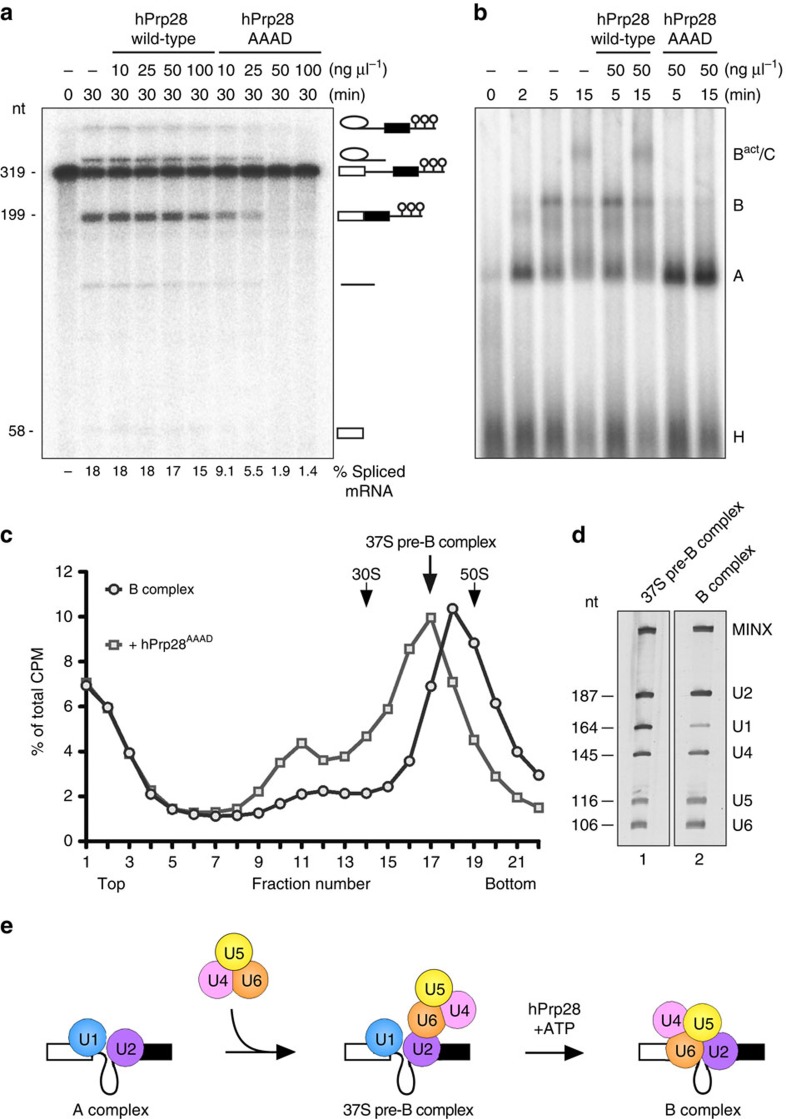
An excess of ATPase-deficient hPrp28 stalls splicing before spliceosomal B complex formation.(a) In vitro splicing of 32P-labelled MINX-MS2 pre-mRNA in HeLa nuclear extract in the presence of increasing amounts (10–100 ng μl−1) of recombinant hPrp28 or an AAAD mutant (hPrp28AAAD) thereof, as indicated above each lane. RNA was analysed by denaturing PAGE and visualized by autoradiography. The positions of the pre-mRNA, and splicing intermediates and products are indicated on the right. The nucleotide length of the pre-mRNA, mRNA and 5′ exon is indicated on the left. The % spliced mRNA is indicated below each lane. The average % spliced mRNA±s.d. (from three independent experiments) observed in the presence of 50 and 100 ng μl−1 hPrp28AAAD was 2.65±0.80 and 2.05±0.77, respectively. (b) Analysis of splicing complexes formed in nuclear extract in the presence of 50 ng μl−1 hPrp28 or hPrp28AAAD by agarose gel electrophoresis in the presence of heparin. The positions of H, A, B and Bact/C complexes are indicated. (c) Splicing complexes were assembled on 32P-labelled MINX-MS2 pre-mRNA in HeLa nuclear extract for 6 min either in the absence or presence of an inhibitory concentration (50 ng μl−1) of the recombinant hPrp28AAAD protein, and were analysed on a 10–30% glycerol gradient containing G-150 buffer. The percent of total radioactivity in each gradient fraction is plotted. Sedimentation values were determined using prokaryotic ribosomal subunits run in parallel. (d) Spliceosomal complexes in peak fractions (37S pre-B, fractions 16–18; B complex, fractions 17–19) were subjected to MS2 affinity selection and RNA was analysed by denaturing PAGE followed by silver staining. RNA identities are indicated on the right. Nucleotide length (nt) markers are derived from the snRNAs from purified human 37S cross-exon complexes run in parallel. (e) Schematic of the spliceosome assembly stages leading to a pre-catalytic B complex.